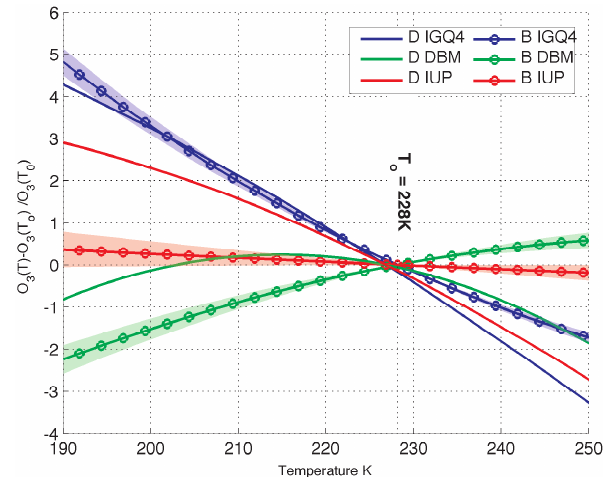
Fig. 6. Dobson AD pair and Brewer calculated total ozone error due to temperature dependence of the various cross-section data sets. The brewer lines correspond to the nominal brewer and the shaded area indicates one standard deviation calculated from the RBCC-E set. In a cooler stratosphere the Dobson (labeled as D) and Brewer instruments (labeled B) underestimate the ozone using IGQ4 (B&P) and IUP cross sections, whereas they overestimate it if we use DBM. The Brewer temperature dependence of the IUP case is very